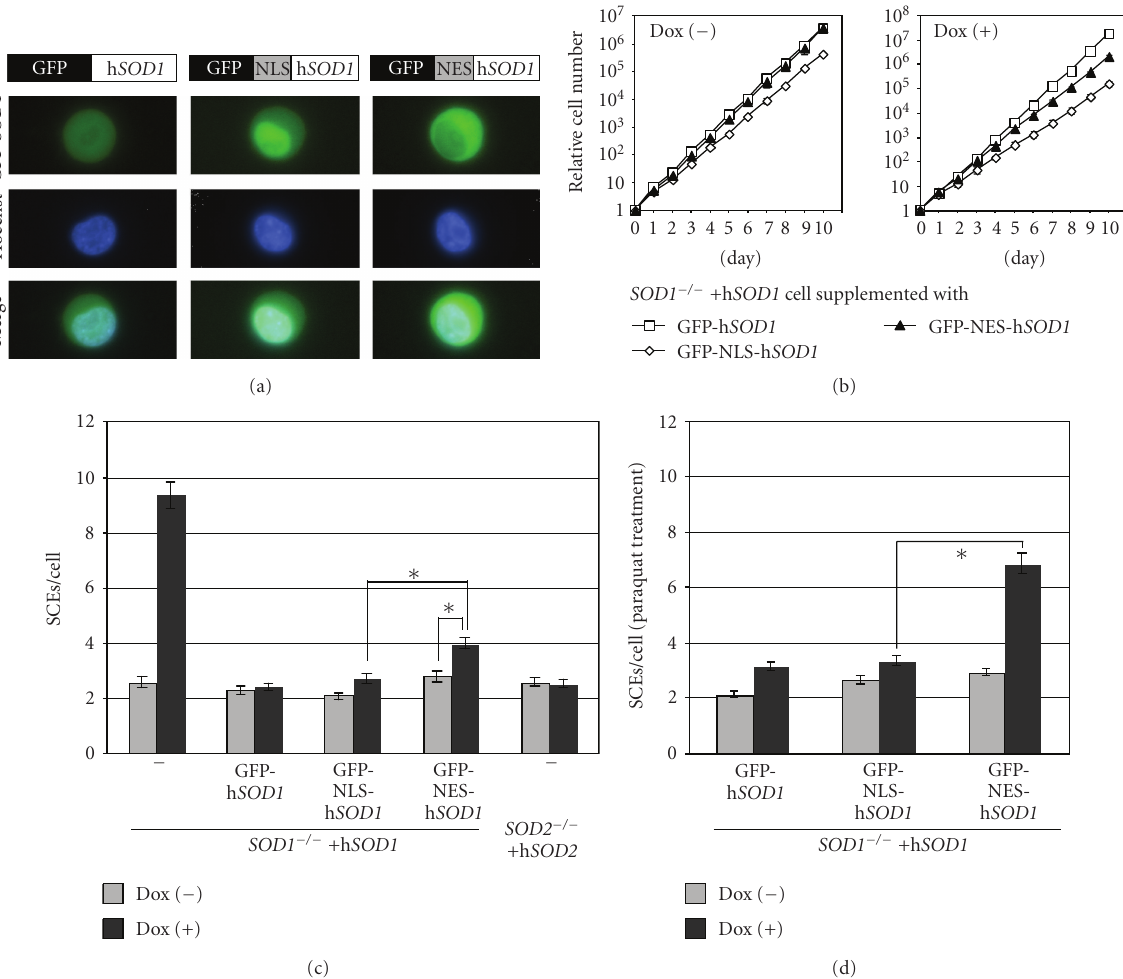
Figure 5: Exclusion of SOD1 from nuclei increases SCE. (a) Distribution of SOD1 with NLS or NES localization signal. Upper panels show the subcellular localization of GFP-hSOD1 with and without localization signals. The middle and lower panels indicate Hoechst staining and merged images, respectively. (b) Growth curves of SOD 1 − / − + h SOD1 cells complemented with indicated hSOD1. Cells were cultured in the presence or absence of 1 μ g/mL Dox. (c) SCE frequency. SCE frequencies of SOD 1 − / − + h SOD1 cells expressing the indicated hSOD1 or those of SOD 2 − / − + h SOD2 cells cultured in the presence or absence of 1 μ g/mL Dox for 120 hours were measured. Bars indicate standard errors. ∗ ; student t -test, P < . 01. (d) SCE frequency in the presence of paraquat. Paraquat was added at a final concentration of 100 μ M to the culture medium 20 hours prior to harvesting. SCE frequencies of SOD 1 − / − + h SOD1 cells expressing the indicated hSOD1 in the presence or absence of 1 μ g/mL Dox for 120 hours were measured. Bars indicate standard errors. ∗ ; student t -test, P < .